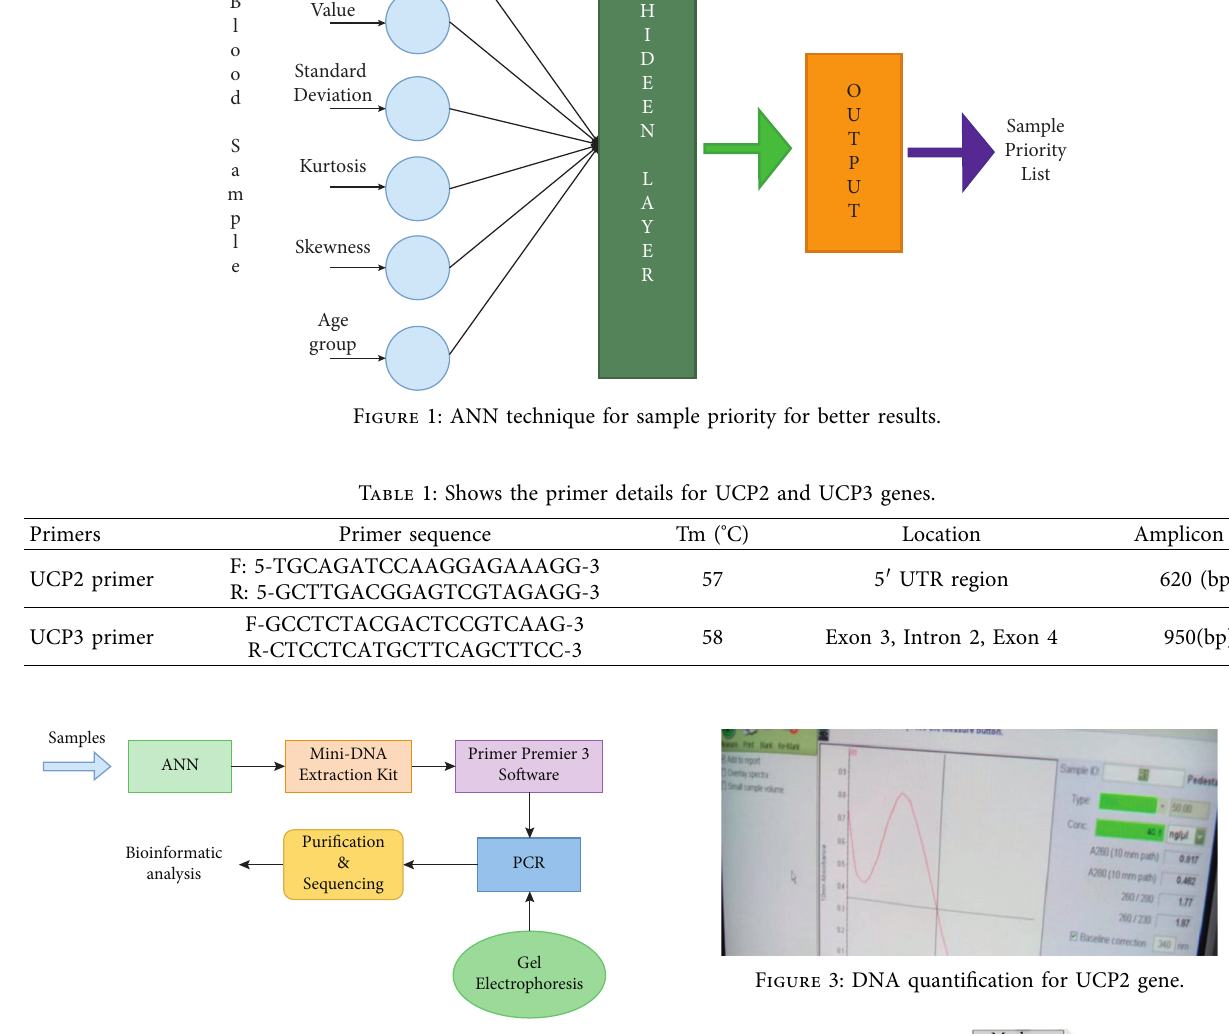
Figure 2: Flow chart of the investigation model.